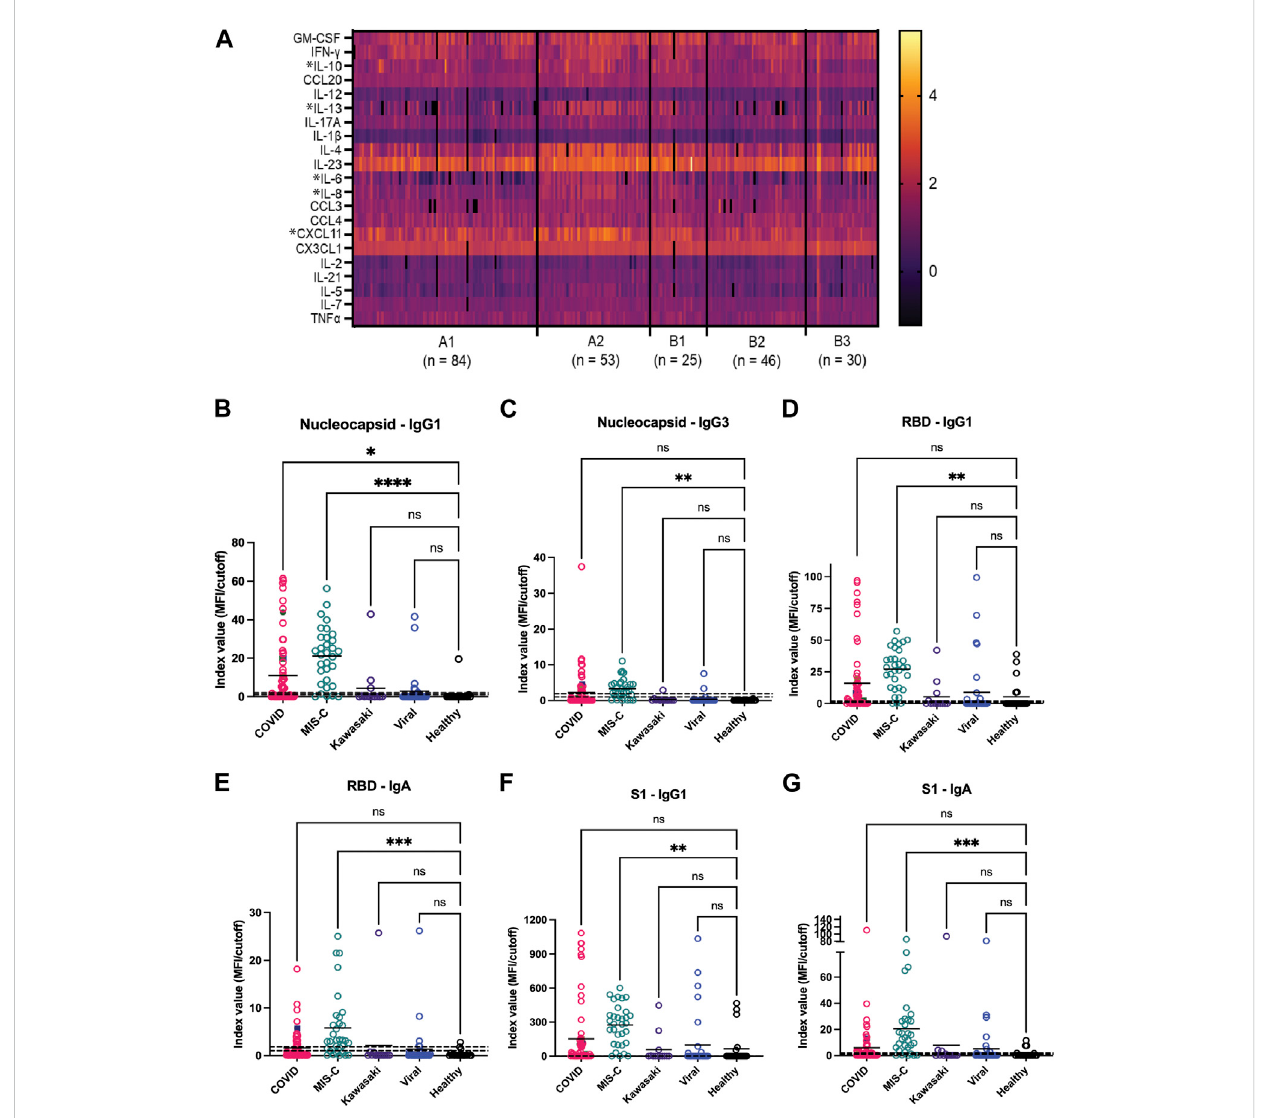
FIGURE 7 Potential analytes found by MIA can inform the evolving composition of a second generation GCFP biosensor chip. (A) A heat map was generated frommicrosphereimmunoassayfromserumsamplesforeachcohort.*Indicatesasigni fi cantdifferenceinthatcytokinefortheA2cohortforCXCL11,IL- 8, IL-6, IL-4, IL-13, & IL-10 analytes. (B – G) The antibody response to the SARS-CoV-2 nucleocapsid and spike components (full spike, RBD, S1, S2), the MIS-C cohort had a signi fi cantly higher IgA response to SARS-COV-2 spike domains as compared to the COVID-19 cohort. One-way ANOVA analysis was performed (* = p < 0.05, ** = p < 0.01, *** = p < 0.001, **** = p <